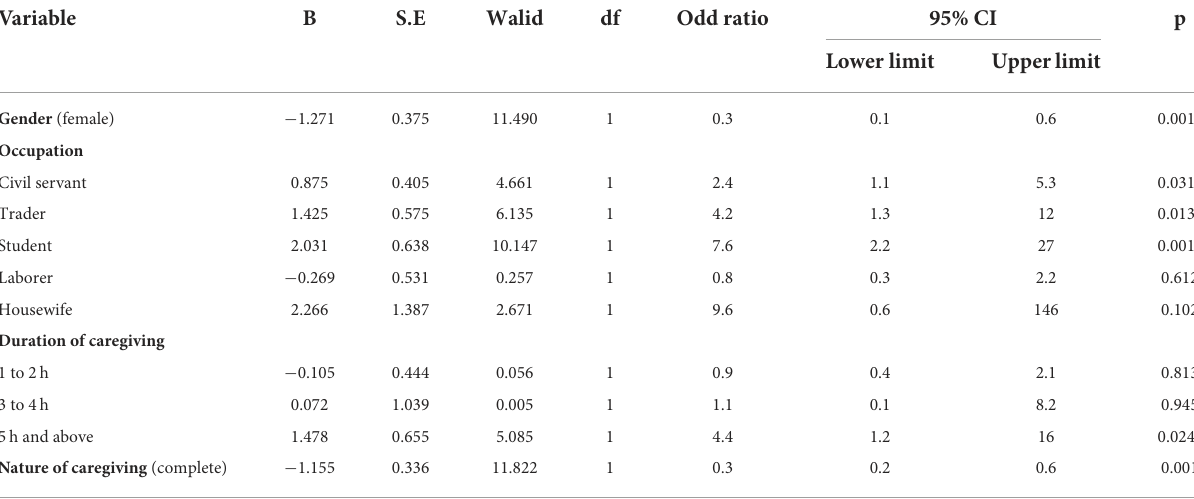
TABLE 4 Predictors of likelihood of presence of low back pain among caregivers of stroke survivours. Variable